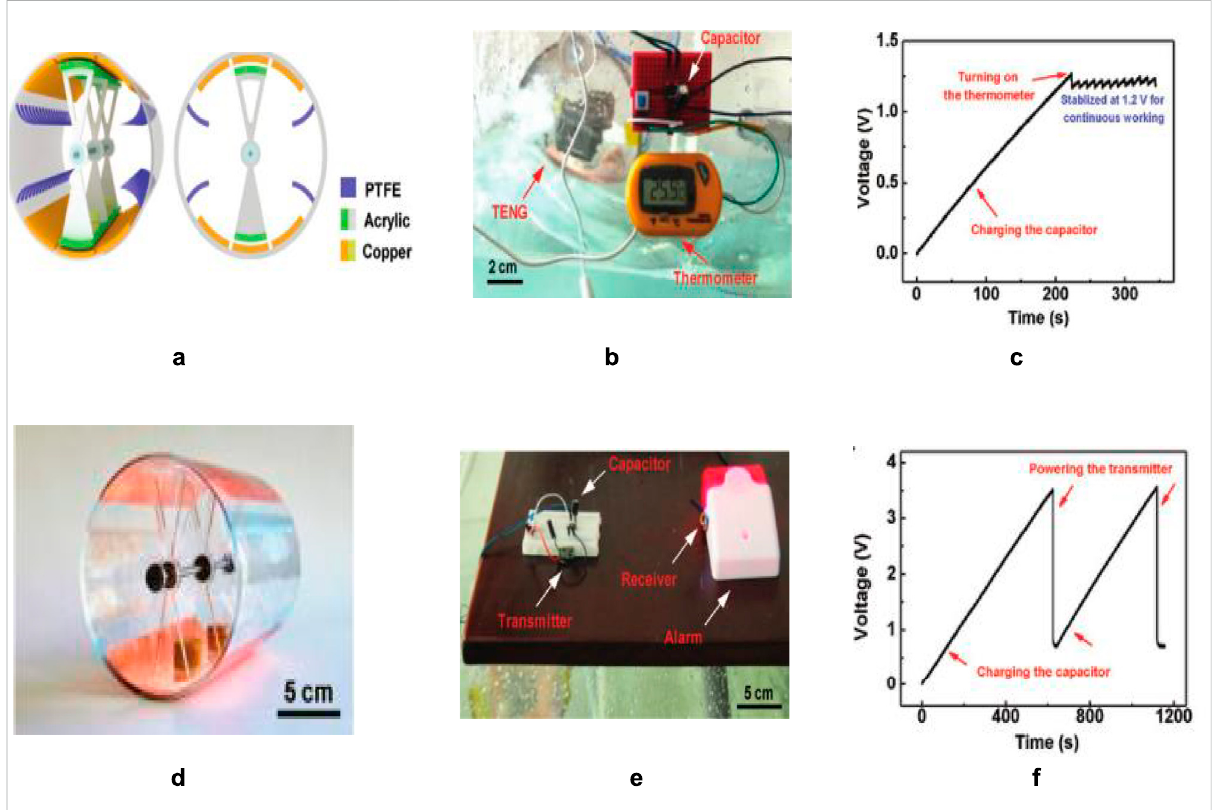
FIGURE 12 (A) SchematicdiagramoftheSS-TENGstructureandcross-section. (B) PhotographofadigitalthermometerpoweredbyanSS-TENGdrivenby water waves. (C) Charge/discharge process of a 220 µF capacitor powering a thermometer at 10 cm amplitude and 1.2 Hz wave frequency. (D) Physical view of the SS-TENG. (E) Photograph of the wireless transmitter. (F) Charging and discharging process of a 220 µF capacitor powering a transmitter for two consecutive transmitting cycles (Jiang et al.,